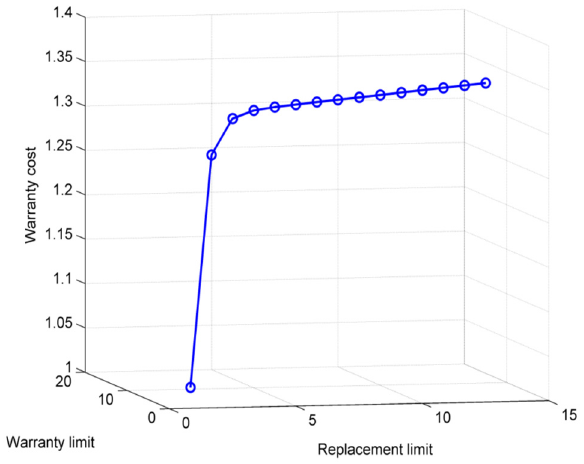
Figure 3. Warranty cost versus m and n .